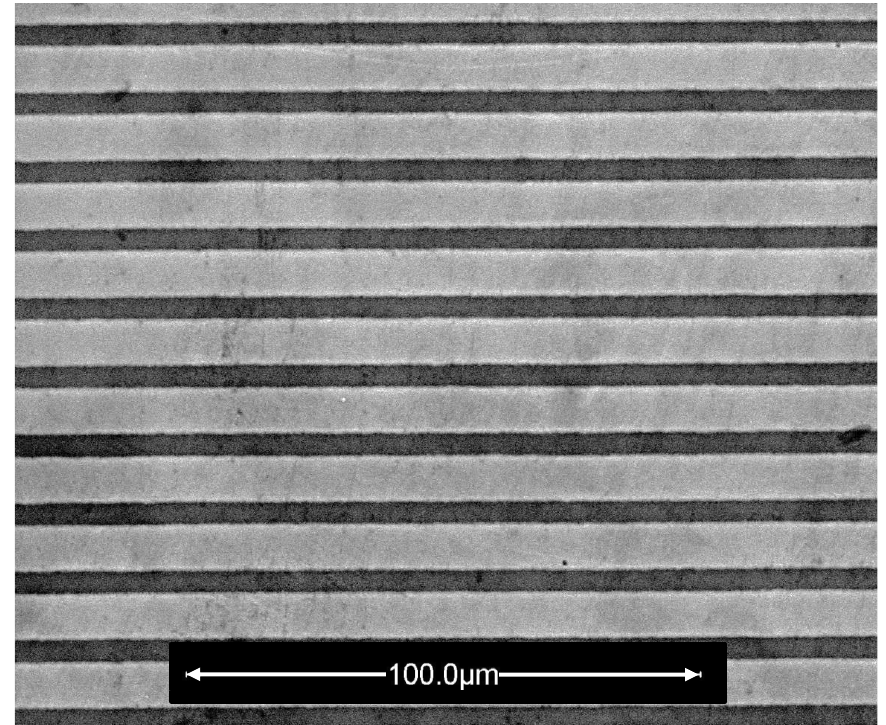
Figure 6. Scanning electron microscopy image of the Py stripe array studied by PNR. The Py stripes appear in light gray, the spaces in between show a dark-gray